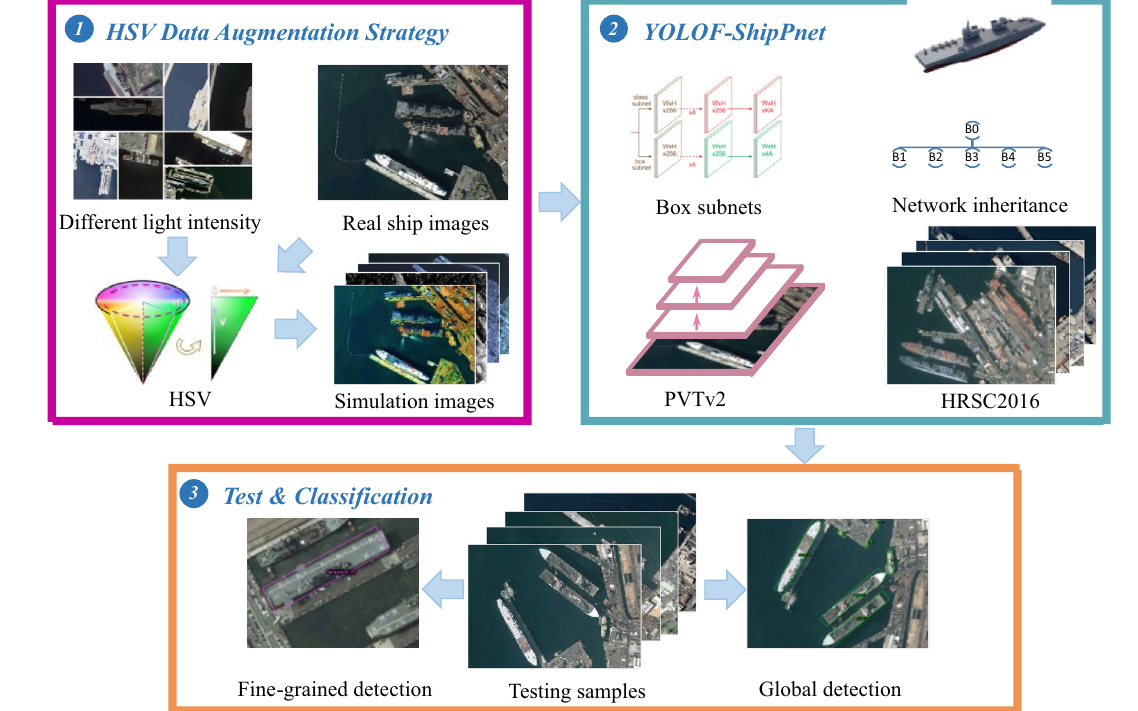
Fig. 4 Design flowchart of